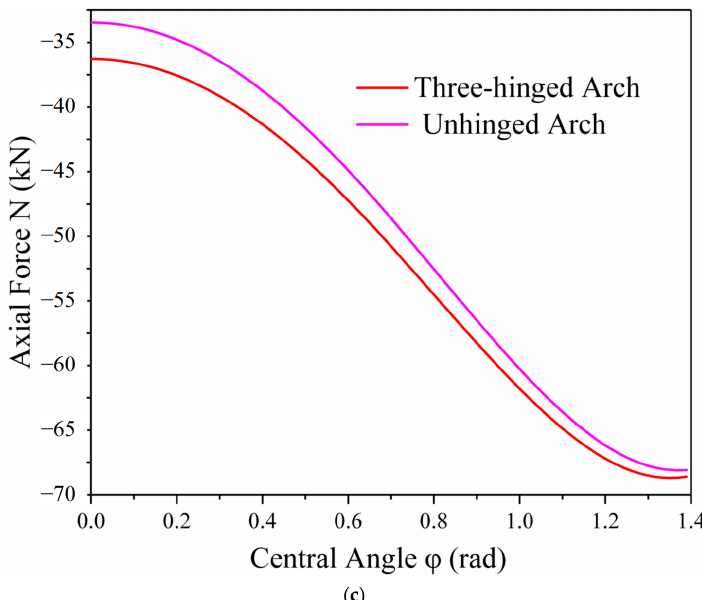
Figure 10. Section internal force of right arch ring according to internal force formula of the un- hinged arch and three-hinged arch: ( a ) bending moment M ; ( b ) shearing force Q ; and ( c ) axial force N .